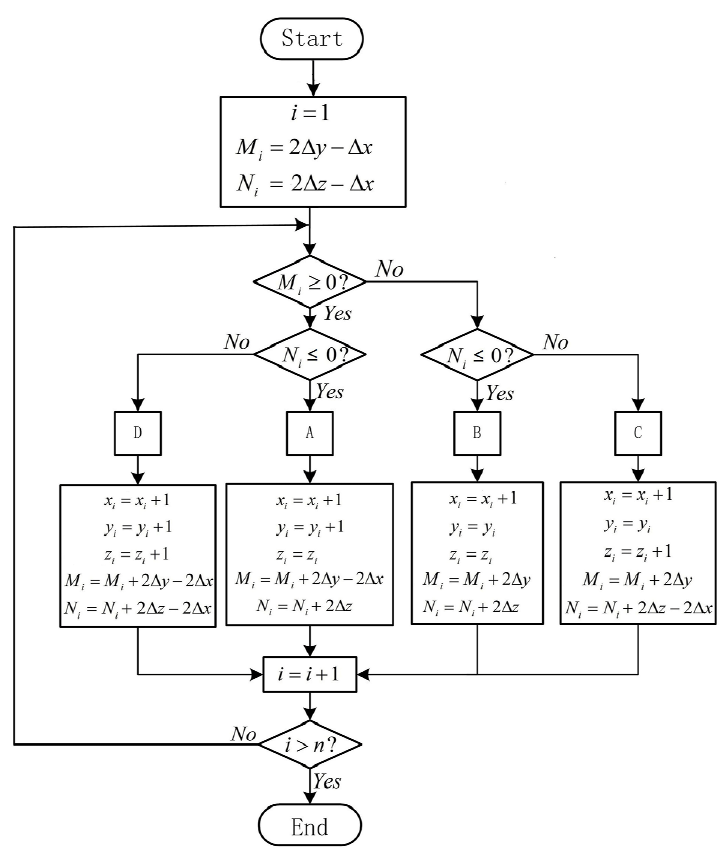
Figure 5. The judging algorithm flow chart for determining the next point.